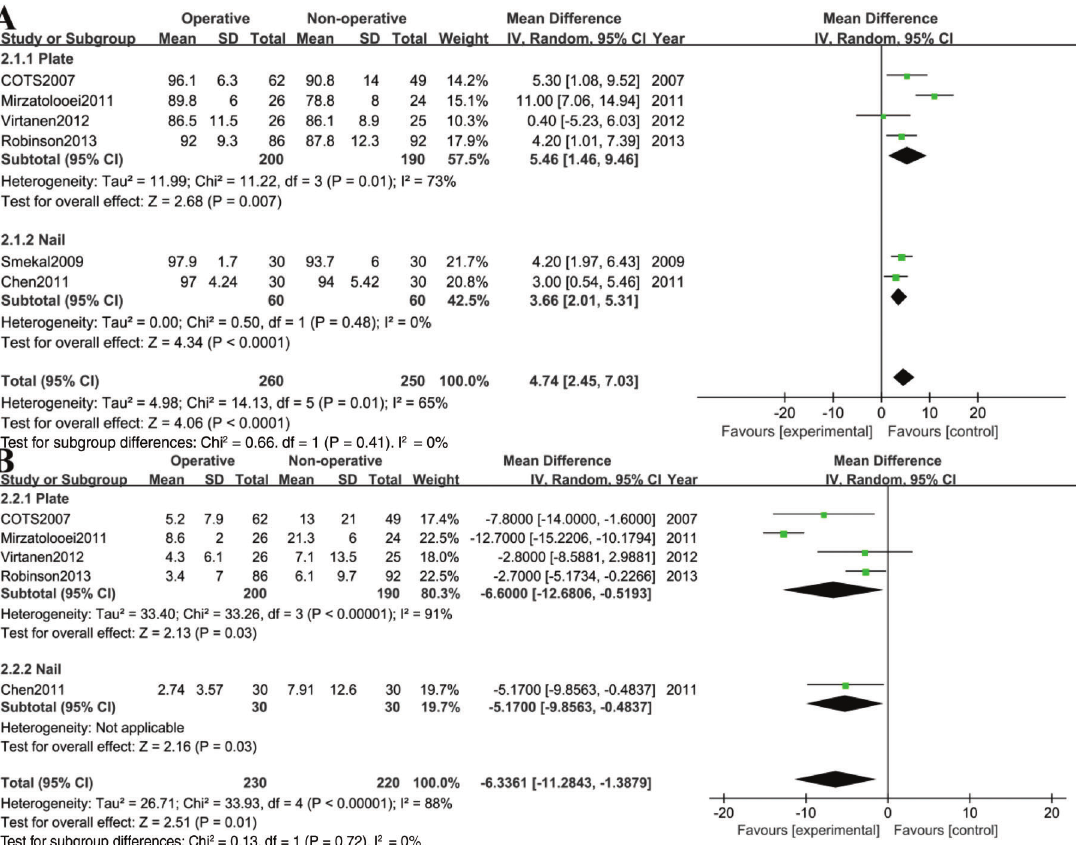
Figure 3 - Forest plot showing comparison of Constant scores (A) and DASH scores (B) between operative (experimental) and nonoperative (control)